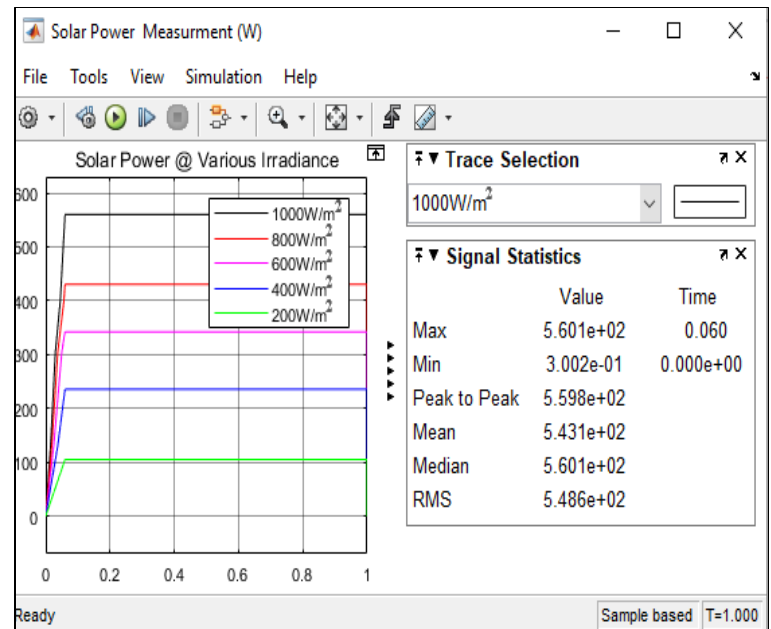
Figure 9. P solar at different load settings by ANFIS model.